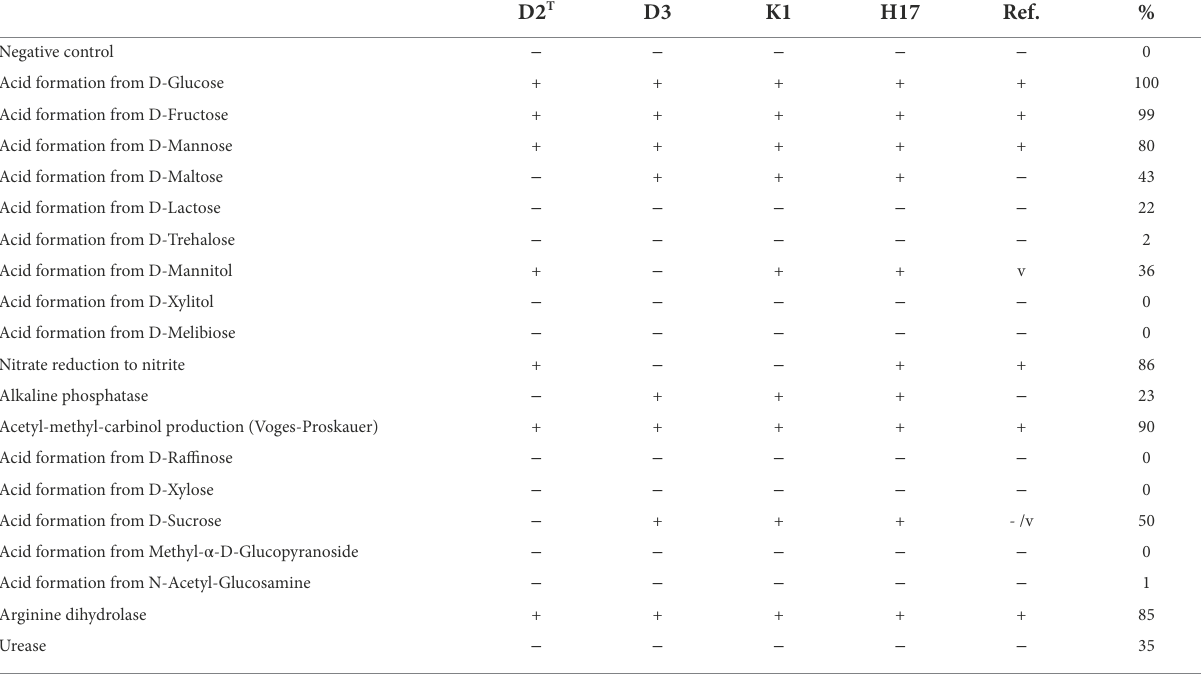
TABLE 2 Test results of all strains in the API® Staph Test after 24 h of incubation at 37 ° C and addition of